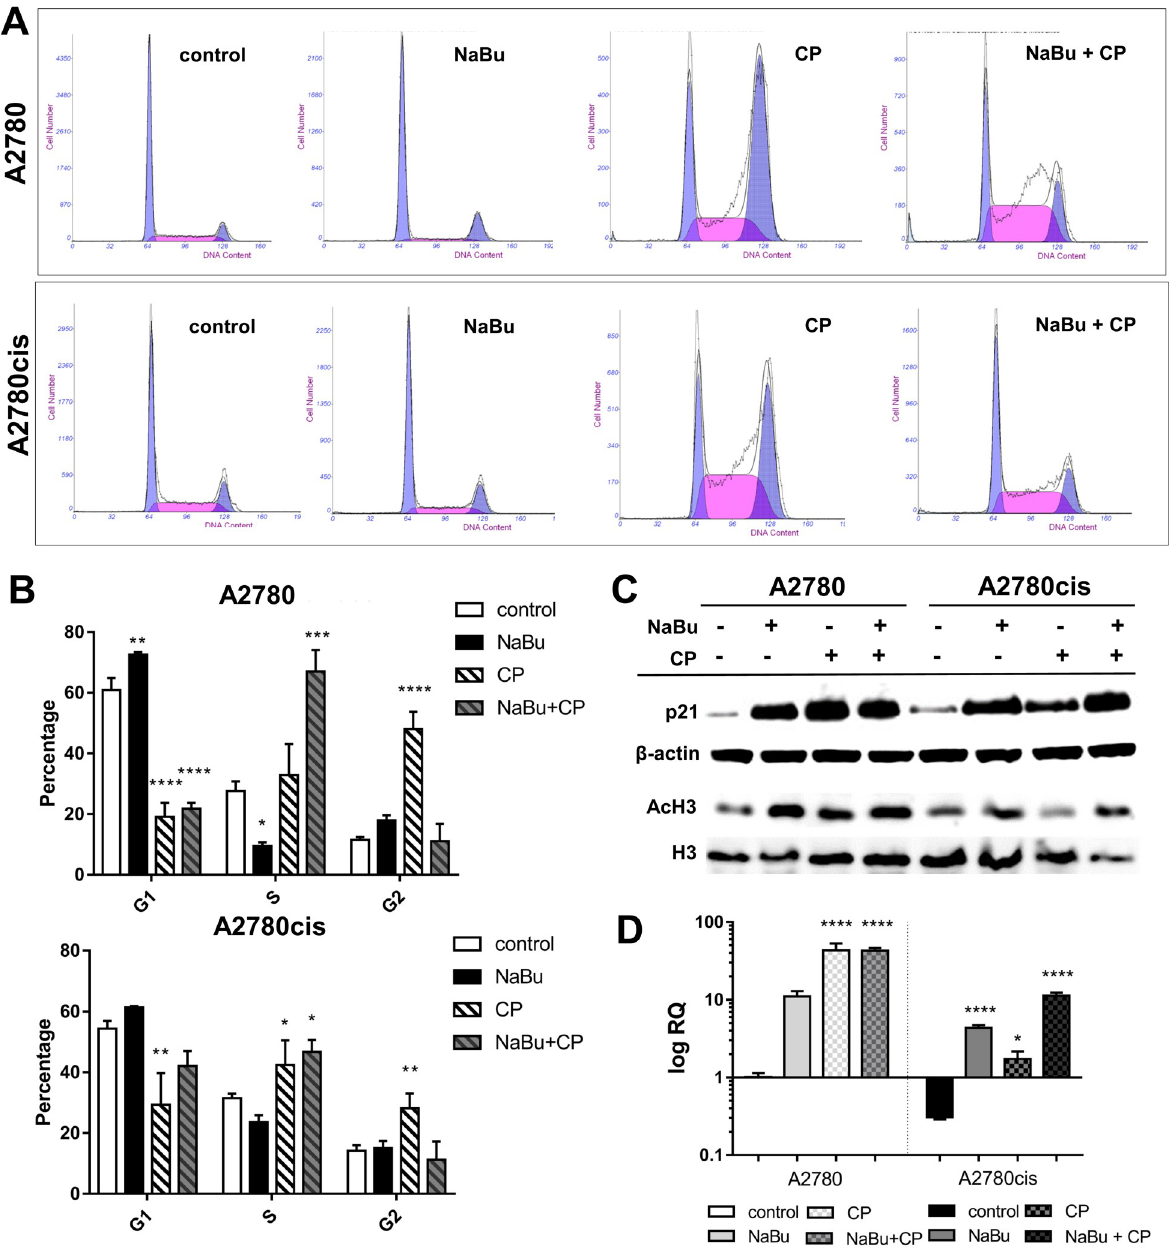
Fig 2. Effect of cisplatin and butyrate on the cell cycle and histone acetylation. Distribution of A2780 and A2780cis cells in G1, S, and G2/M phases of the cell cycle after 5 mM NaBu, 5 μ M CP single-agent treatments and combination of both treatments was measured by flow cytometry (A, B). Panel A shows representative cell cycle analysis histograms. The bar graph (panel B) represents cumulative data on cell cycle distribution in the G1, S, and G2/M phase. The data points in the graph are the means ± SD of 3 independent experiments. Significance was tested using one-way ANOVA ( � P � 0.05, �� P � 0.01, ��� P � 0.001, ���� P � 0.0001 vs. control). p21, histone H3 and acetylated H3 protein amount was detected by immunoblot analysis (C). Blots shown are representative of at least three independent experiments. β -Actin was used as a loading control. Gene expression of CDKN1 in A2780 and A2780cis cells was measured using qPCR (D). The results were normalized for the HPRT expression. Data are presented as means ± SD of 3 independent experiments. Significance was tested using one-way ANOVA. ( � P � 0.05, �� P � 0.01, ��� P � 0.001, ���� P � 0.0001 vs.